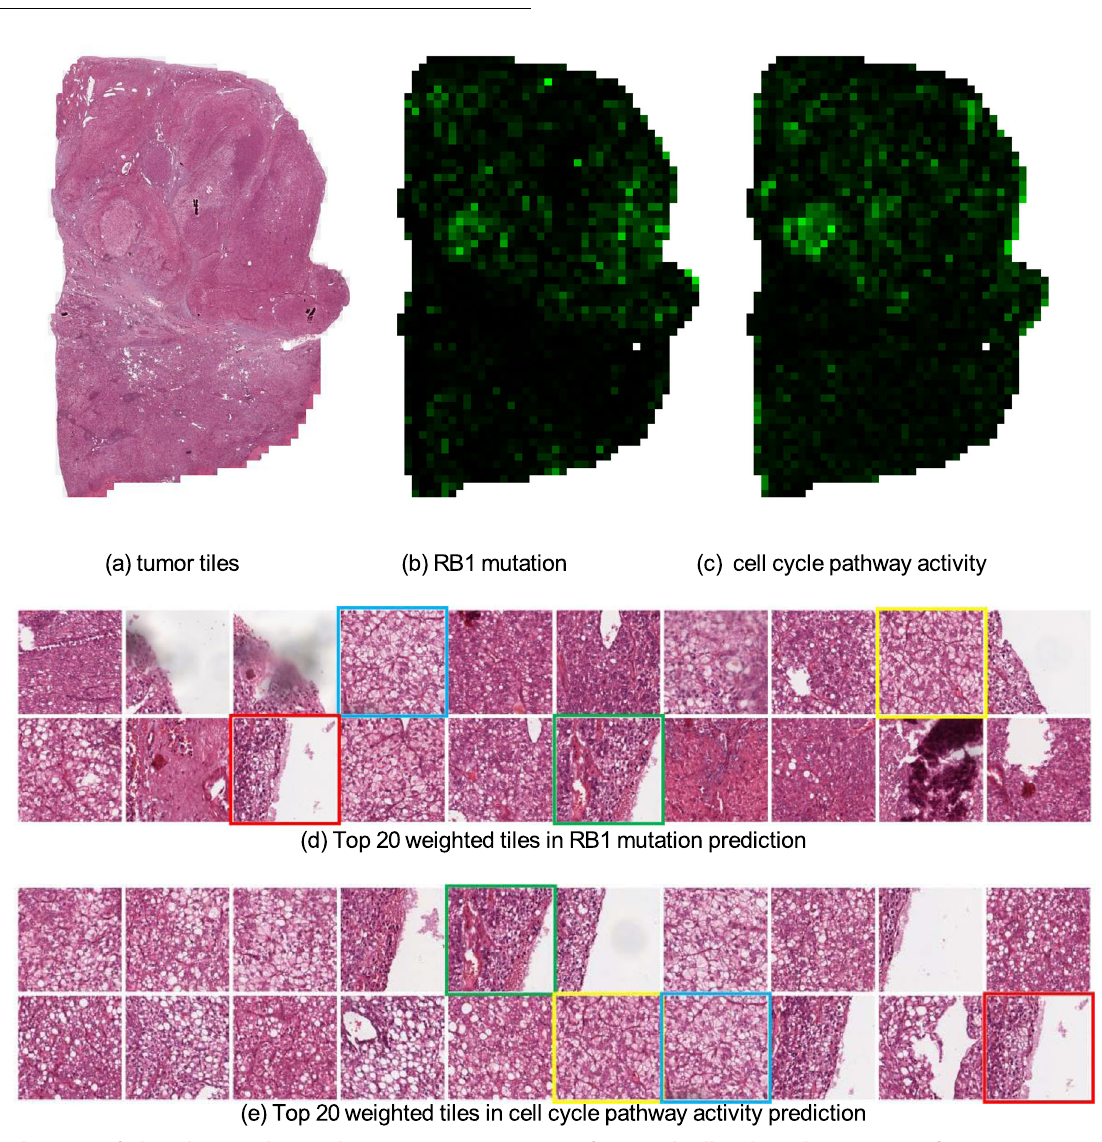
Fig. 6 Weight maps of tiles when predicting the point mutation status of RB1 and cell cycle pathway activity from mRNA expression data in liver cancer. a Tumor tiles after data processing. b Weight map of tumor tiles in RB1 point mutation prediction. Brighter green tiles have larger weights. c Weight map in cell cycle pathway activity prediction. d, e Top 20 weighted tiles from RB1 point mutation prediction and cell cycle pathway prediction, respectively. We marked four tiles that appeared in both tasks. These tissues contain hepatocellular carcinoma with clear cell change from a pathologist ’ s